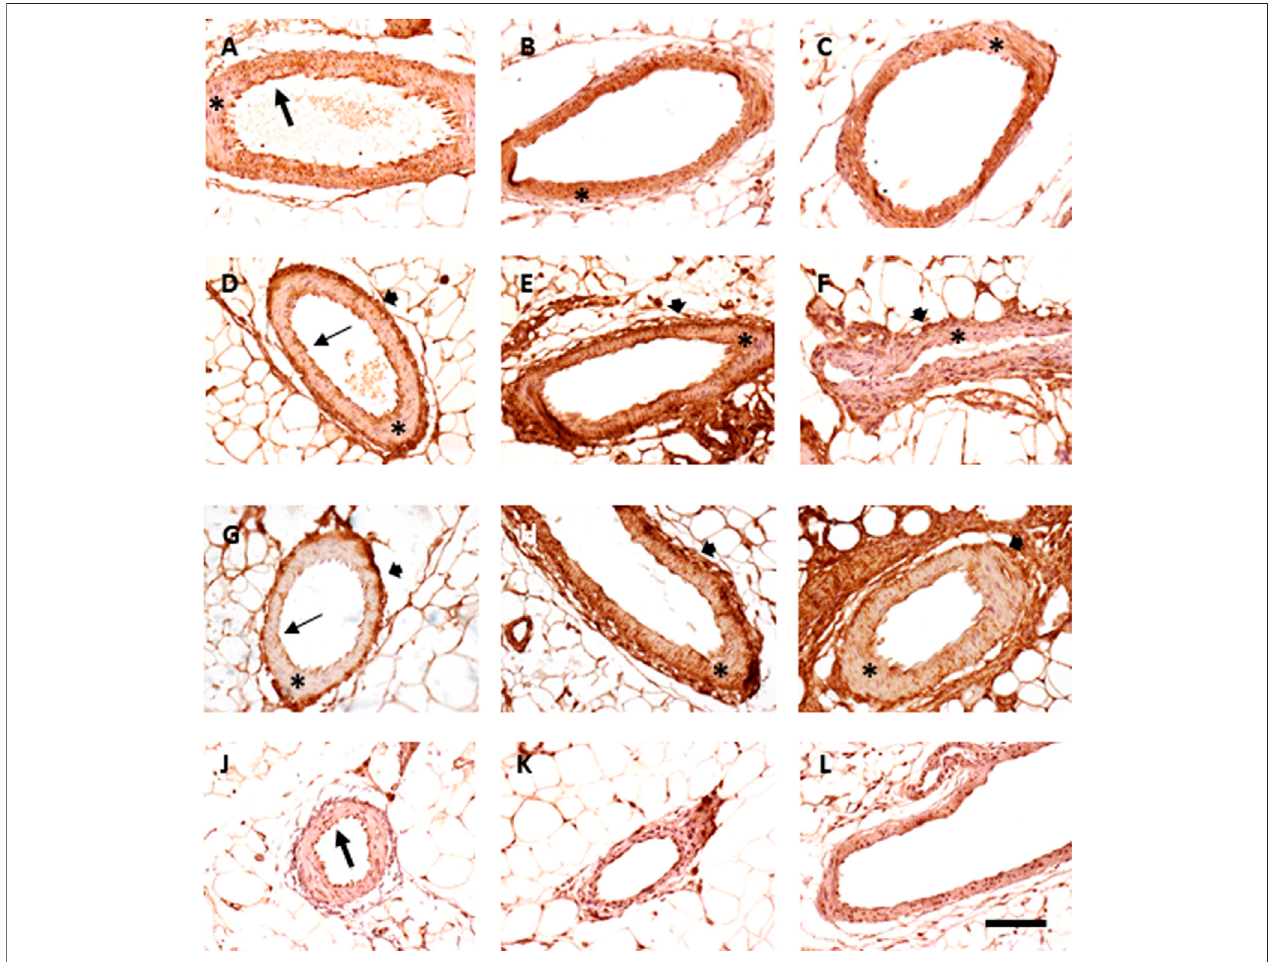
FIGURE 9 | Immunohistochemistry of mesenteric vessels. Expression of TNF α (A – C) , eNOS (D – F) , and connexin 43 (G – I) and iNOS (J – L) . Animals treated with saline (A, D, G, J) , vincristine (B, E, H, K) , and 2 weeks after vincristine administration (C, F, I, L) . Bar: 100 μ m.